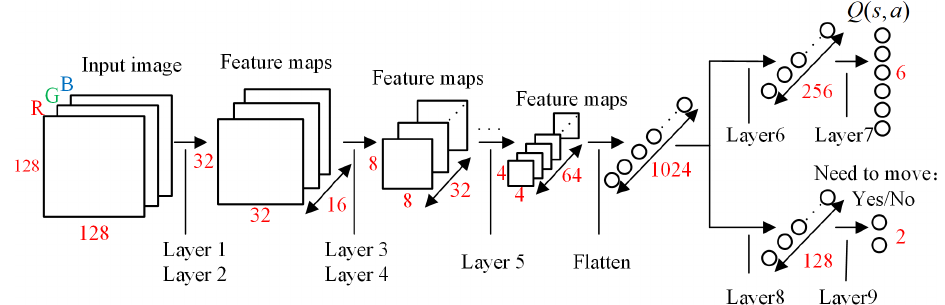
Figure 6. The network structure for the actor estimation. Table 1. Network architecture